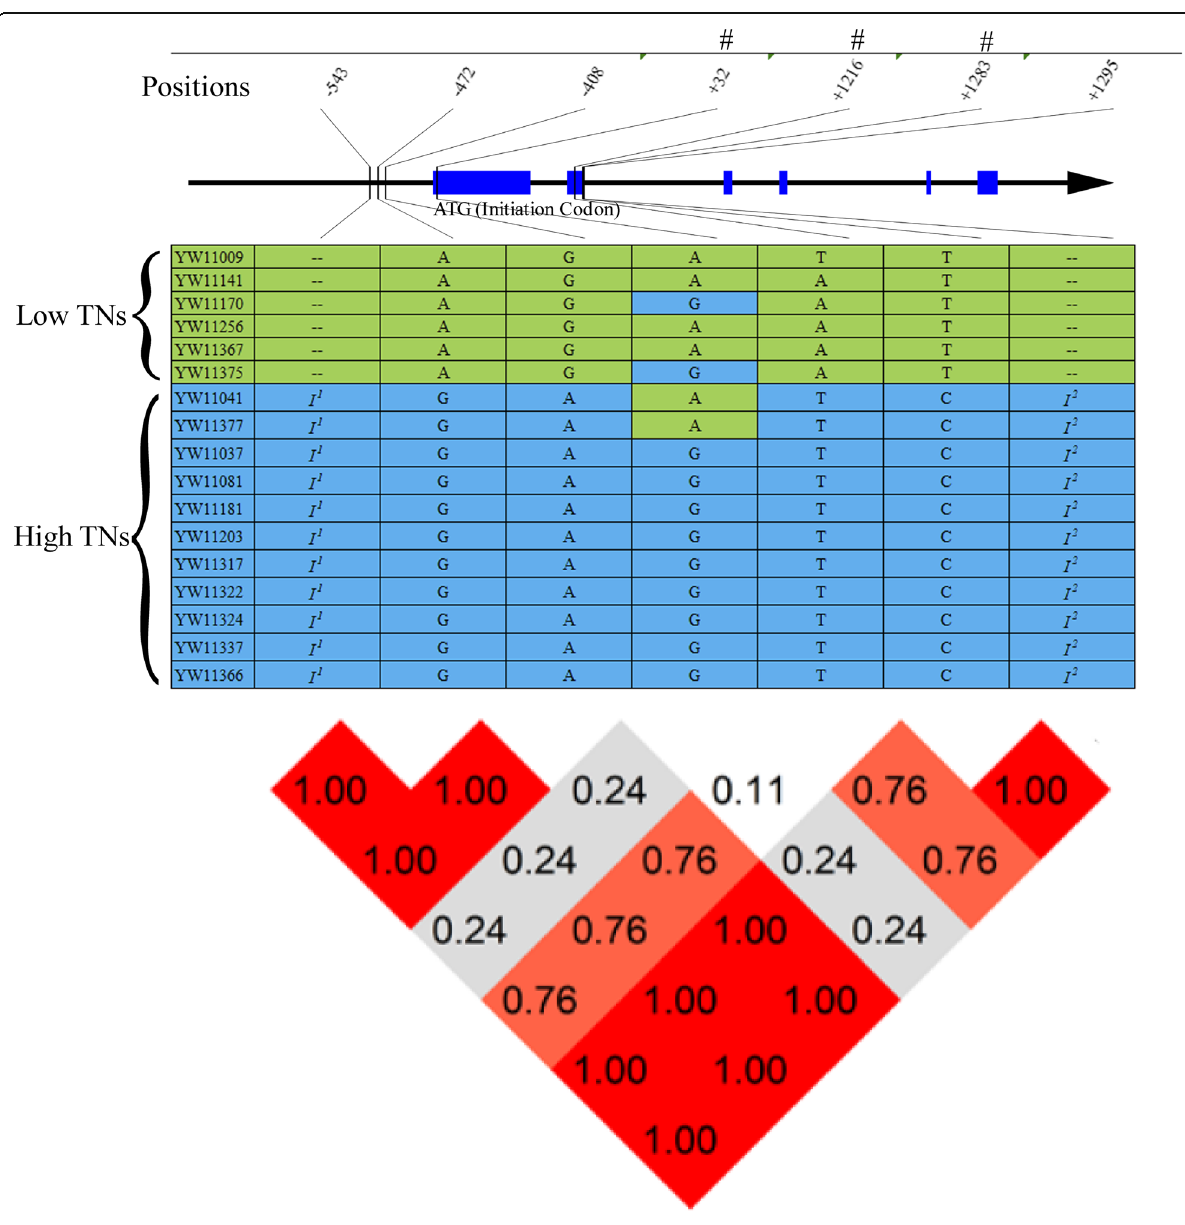
Fig. 4 Sequence analysis of the candidate gene Os07g28890 in the rice accessions with extremely low and high TNs. Tilted numbers at the top indicate the position related to the initiation codon of ‘ ATG ’ ; ‘ - ’ indicates upstream of ‘ ATG ’ ; ‘ + ’ indicates downstream of ‘ ATG ’ ; “ # ” is a synonymous mutation. The middle panel shows the sequence variation in the extreme low and high TN accessions. . ‘ A ’ , ‘ T ’ , ‘ G ’ and ‘ C ’ in the table are the four bases. ‘ -- ’ indicates that the sequences are the same as the reference genome. ‘ I 1 ’ and ‘ I 2 ’ represent insertion of ‘ AGCTAGCTAGCT ’ and ‘ ATGCATCCATATATCATGATCTAGCAGGTATCATTATACTCTACATATTGTCAATTTTTTTCAGAATTTTTCACAACTATTTGCATCGAATTTGGAAGAAAAAGGTAT ACTAGGGGATATCCCCTCGAGGGATTAGAATCCACTCCCTTTCTAAATTAATGTACTATTTGATTATTGTTTTATTCAAAAA ’ mutations, respectively. The bottom panel is the LD-decay of the TN variation in the region. The LD values are included in the blocks with different